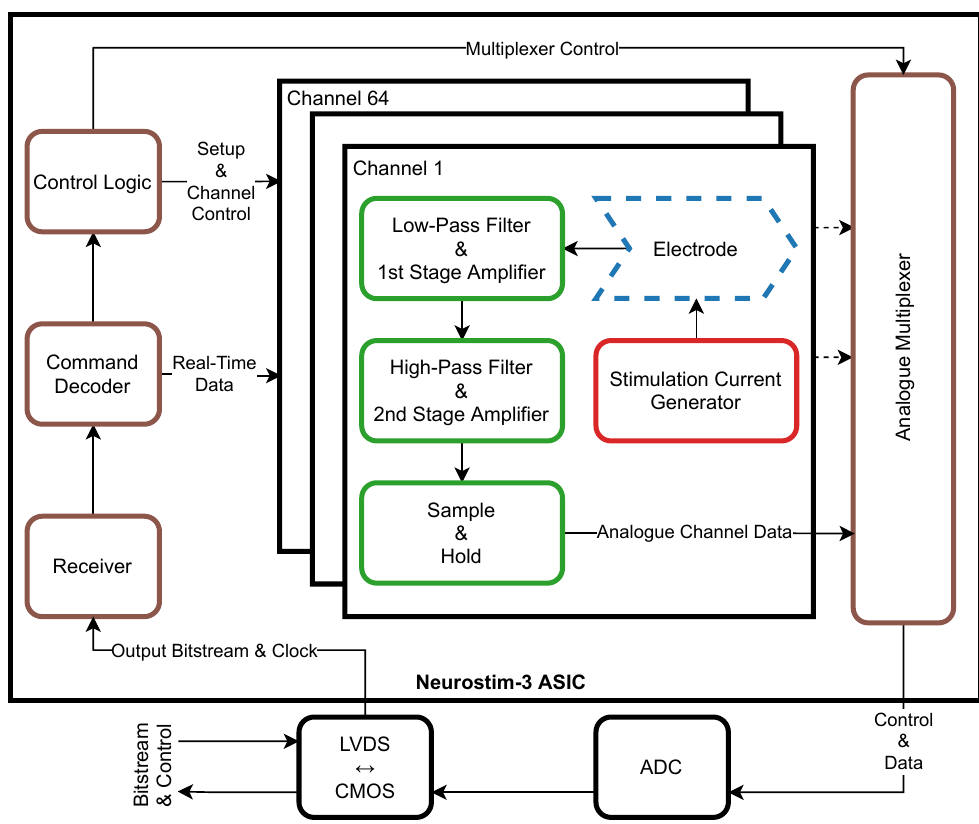
Figure 2. Data processing pipeline performed on the AB. Output Bitstream created by Server and distributed by IB comes to the Neurostim-3 ASIC. Before passing it to the ASIC, it is required to be converted back to a single-ended signal by Low-Voltage Differential Signalling (LVDS) to Complementary Metal–Oxide–Semiconductor (CMOS) converter. The device decodes the incoming stream of bits in order to prepare its states e.g., gain or cut-off frequencies and execute actions e.g., output current pulses or sample signals from connected MEA. Analogue samples from each channel are then multiplexed, converted to their digital form by Analogue-Digital Converter (ADC) and sent back to the IB as a differential